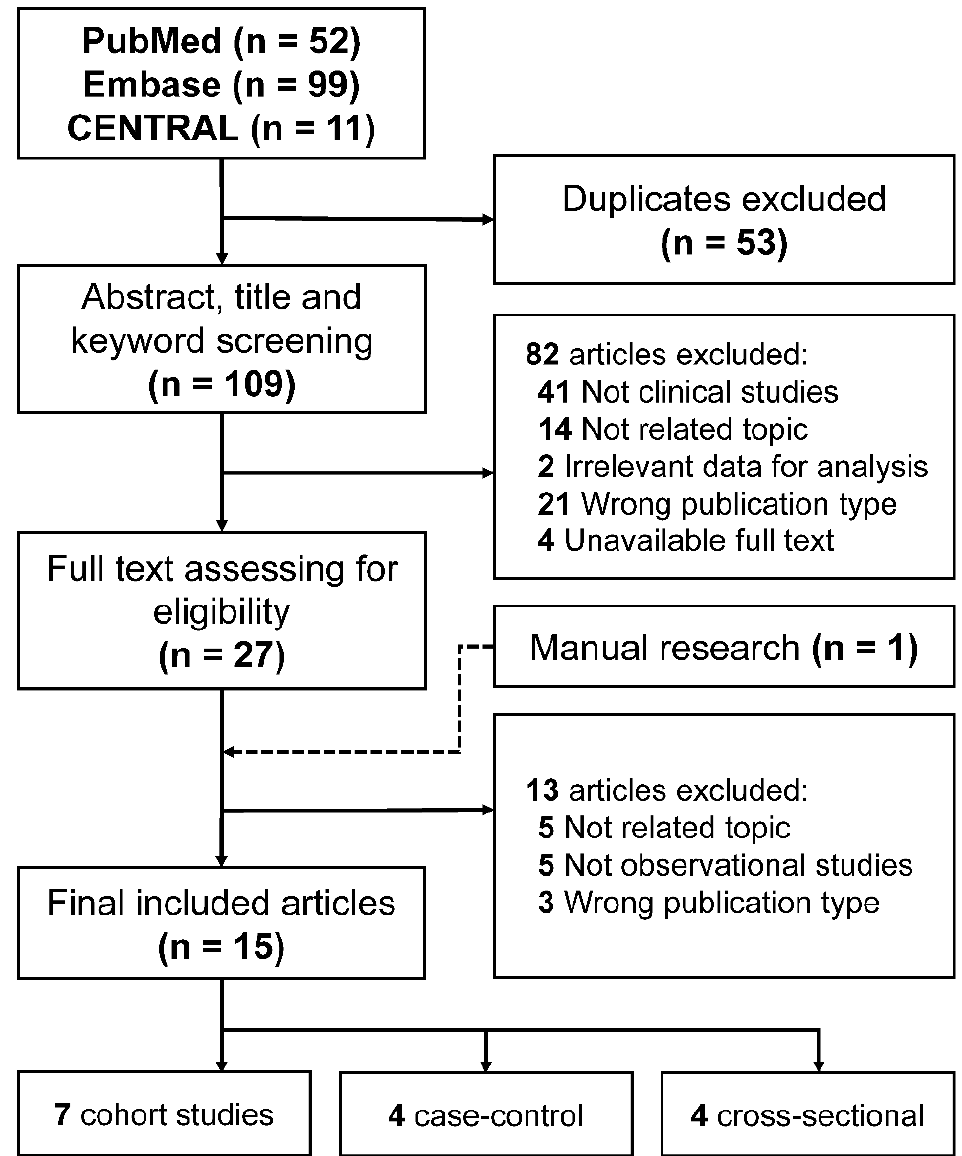
Figure 1. Flowchart of literature selection